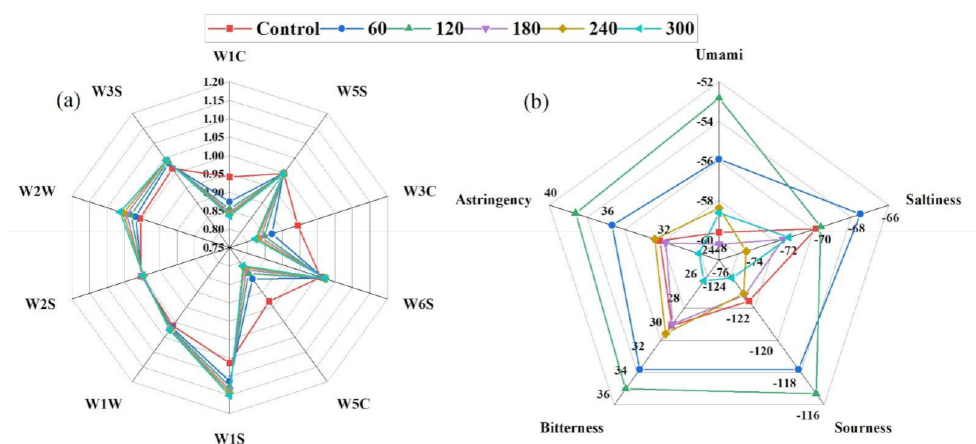
Figure 3. ( a ) Radar plot describing the influence of HVCP treatment on the odour fingerprints of the EWP; ( b ) Radar plot describing the influence of HVCP treatment on the taste fingerprints of the EWP.W1C: Aromatic compounds; W5S: Ammonia and aromatic molecules; W3C: Broad- nitrogen oxide; W6S: Hydrogen; W5C: Methane, propane and aliphatics; W1S: Broad-methane; W1W: Sulphur-containing organics; W2S: Broad-alcohols, broad-carbon chains; W2W: Aromatic, sulphur- and chlorine-containing organics and W3S: Methane and aliphatics. AAE: Umami; CTO: Saltiness; CAO: Sourness; COO: Bitterness and AEI: